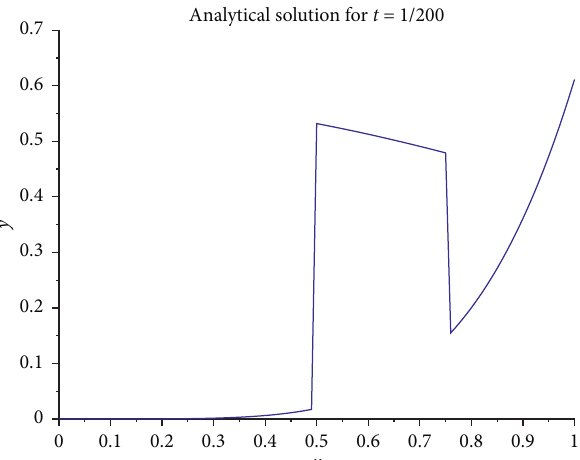
Figure 2: Analytical solution ρ (( 1/20 ) ,x ) for h � ( 1/10 ) and t � ( 1/20 ) ∈ ( 0 , ( 1/10 )] .